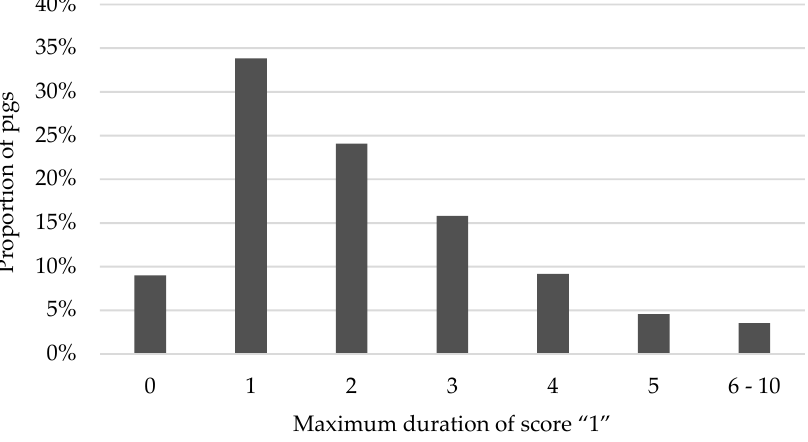
Figure 4. Distribution of the maximum duration of score “1” per pig over rearing and finishing periods.